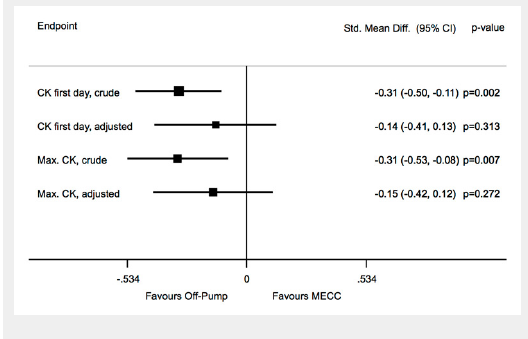
Figure 3 Forest plot regarding the values of CK on the first postoperative day and the peak value of CK.